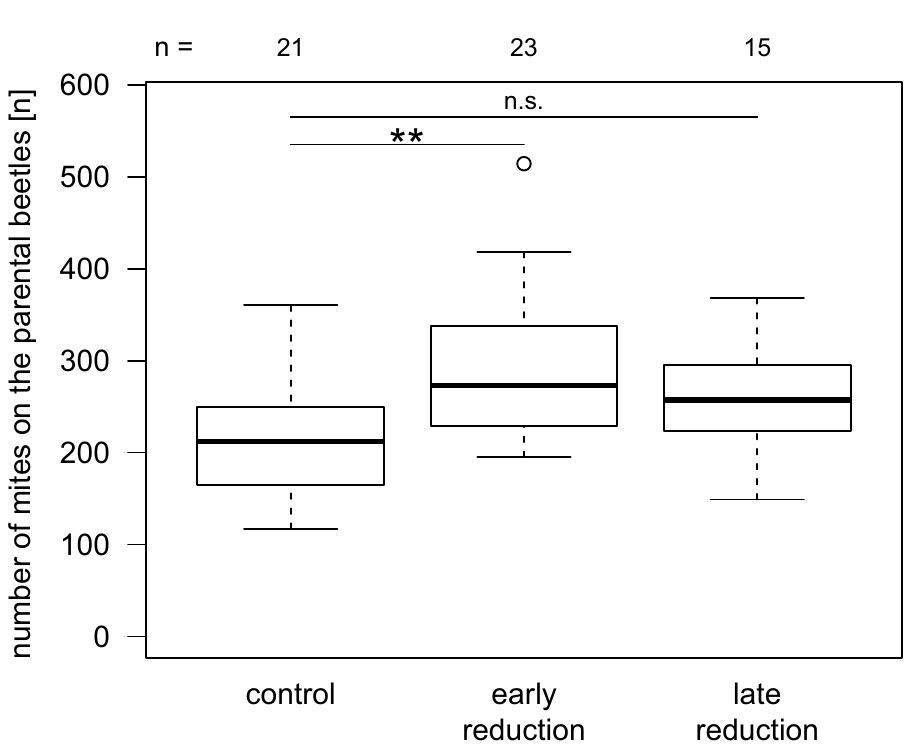
Fig 4. The number of mites that left the carcass with the parental beetles depended on the experimental manipulation of beetle brood size. We experimentally controlled the size of the beetle broods to an average brood size of 12–22 (control) or 7 larvae (reduction). In the low brood size treatments, we removed excessive larvae either when they first arrived at the carcass (early reduction) or three days later (late reduction). Boxplots depict median (thick line), interquartile range (box), minimum and maximum. Numbers are sample sizes; Wald test, �� p < 0.01, n.s. p > 0.05).